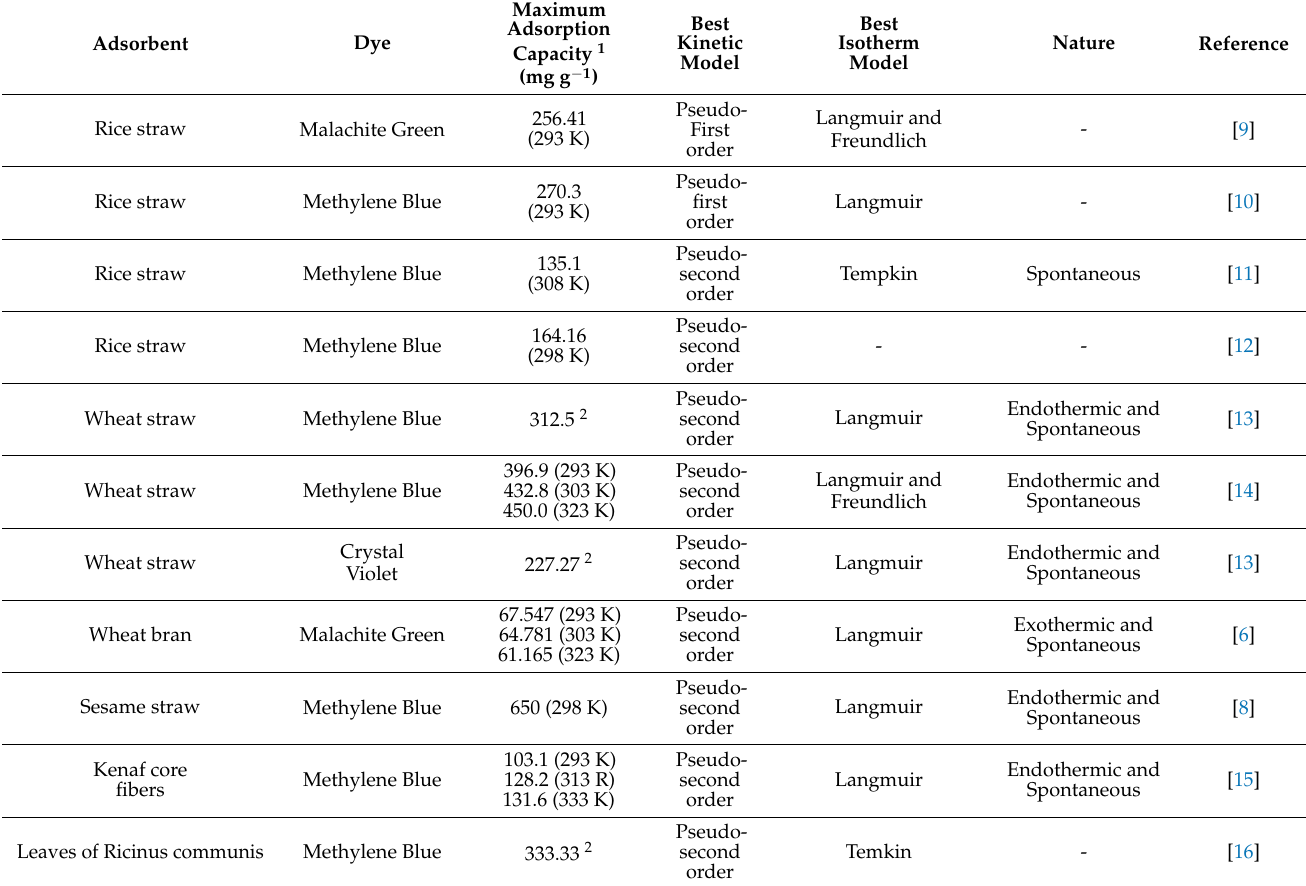
Table 1. Adsorption capacities of citric acid-modified lignocellulosic materials towards cationic dyes.